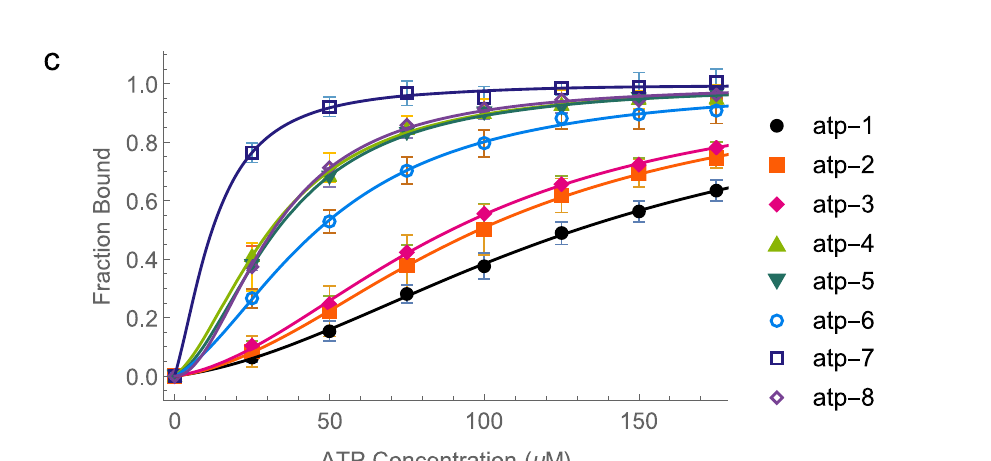
identi fi ed from the high-throughput screen. 50nM fl uorophore - and quencher- labeled ADS construct was incubated with various concentrations of ATP and measured on a plate reader ( n =4 replicates). A two independent binding site modelwasusedto fi ttherawdataandnormalizethebindingsignalsbetween0and 1, as represented by the solid lines. Data are presented as mean values and error bars represent the standard deviation of the measurements. Source data are pro- vided as a Source Data fi